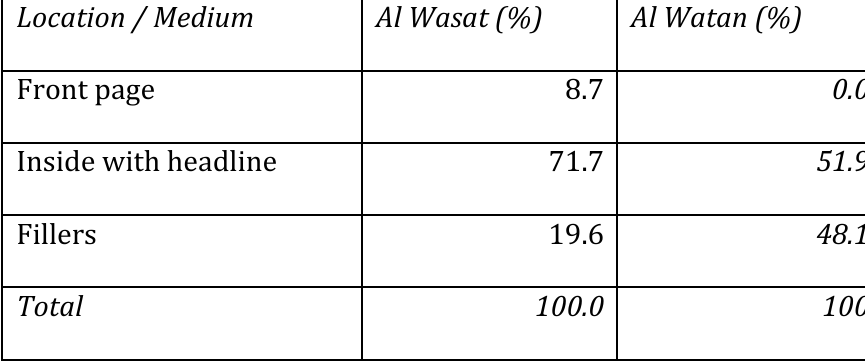
Table 1: Women candidate news‐item location in print media